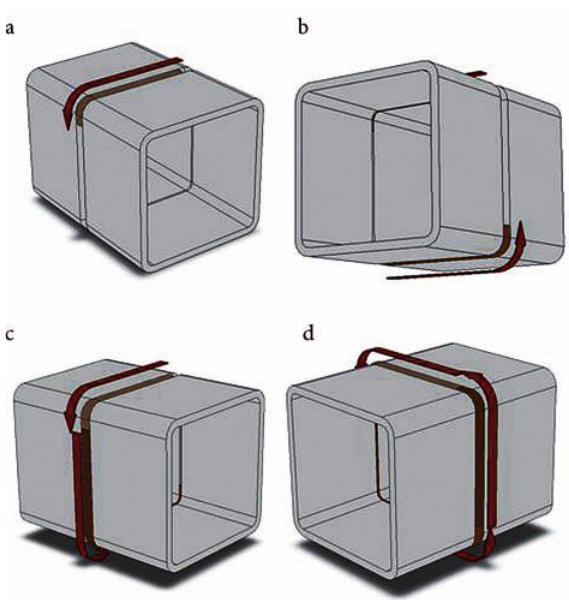
Fig. 2. Modelled sequence of tube butt joint welding